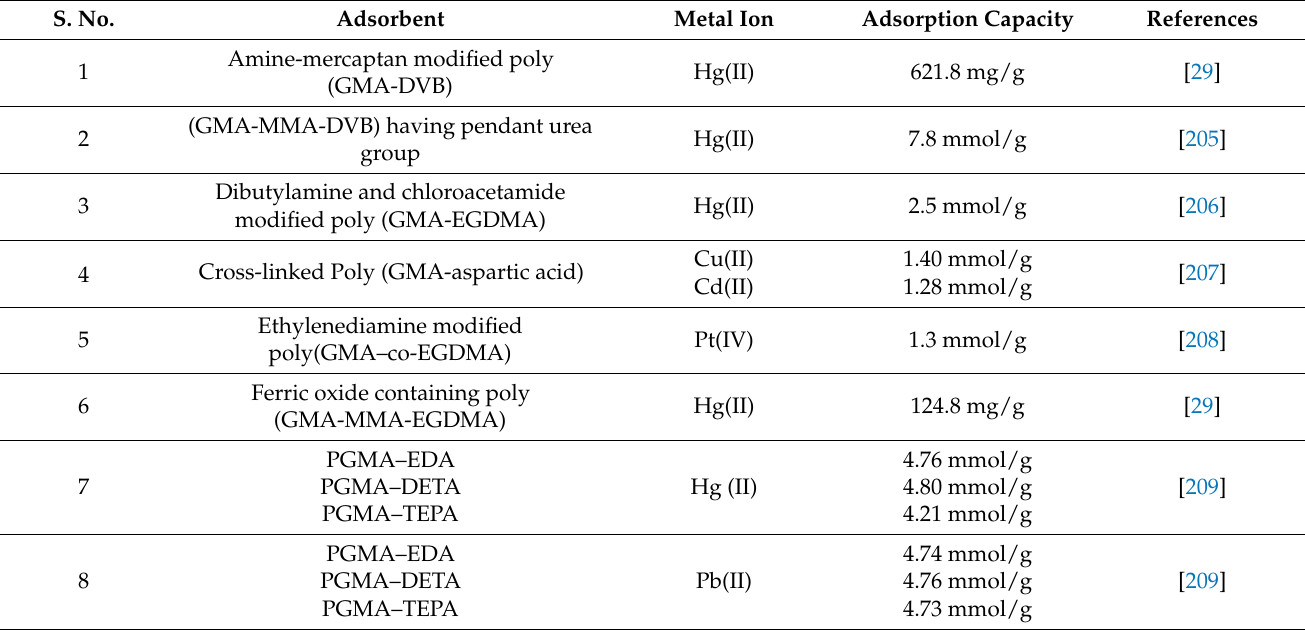
Table 4. Adsorption capacities of functionalised glycidyl methacrylate for removal of toxic metal ions. S.